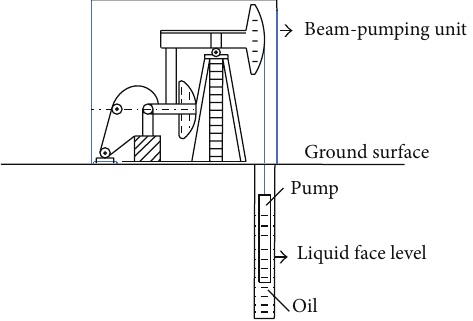
Figure 1: The schematic diagram of beam pumping system.